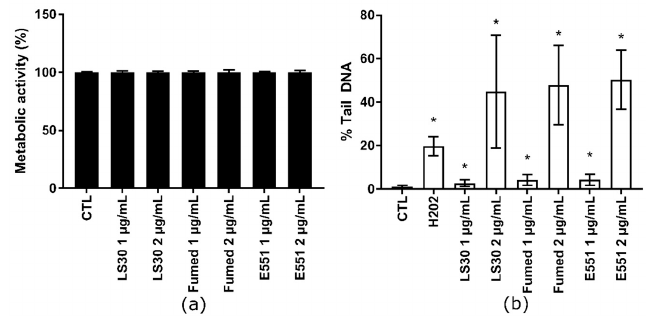
Figure 4. Cytotoxicity of SiO 2 particles, repeated exposure. RAW 264.7 were exposed repeatedly to 1 or 2 µg/mL SiO 2 particles, three times per week for 3 weeks. ( a ) Metabolic activity of RAW264.7 cells measured using the WST-1 assay and ( b ) genotoxicity of SiO 2 particles assessed via alkaline comet assay. Mean ± standard deviation of five replicates (WST-1) and three comet experiments performed independently, with three slides per experiment. Statistical significance: *p<0.05, CTL vs. exposed.